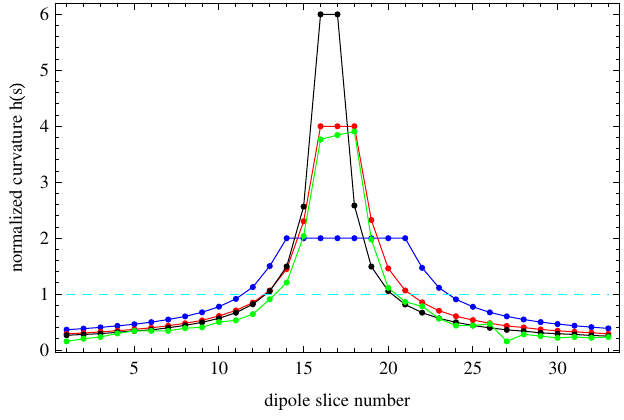
FIG. 3. Optimal bending field profiles (from PGA optimiza- tions) for minimal TME at maximum field strength 2 (blue), 4 (red), and 6 (black) times higher than the reference dipole (dash). The green curve is a multiobjective optimization, which is not fully optimized, with a few percent lower performance. The cyan dashed line is the reference uniform dipole. Note that, in this and the next two graphs, the curves do not represent the field but simply provide a guidance for the actual piecewise constant field represented by the dots.